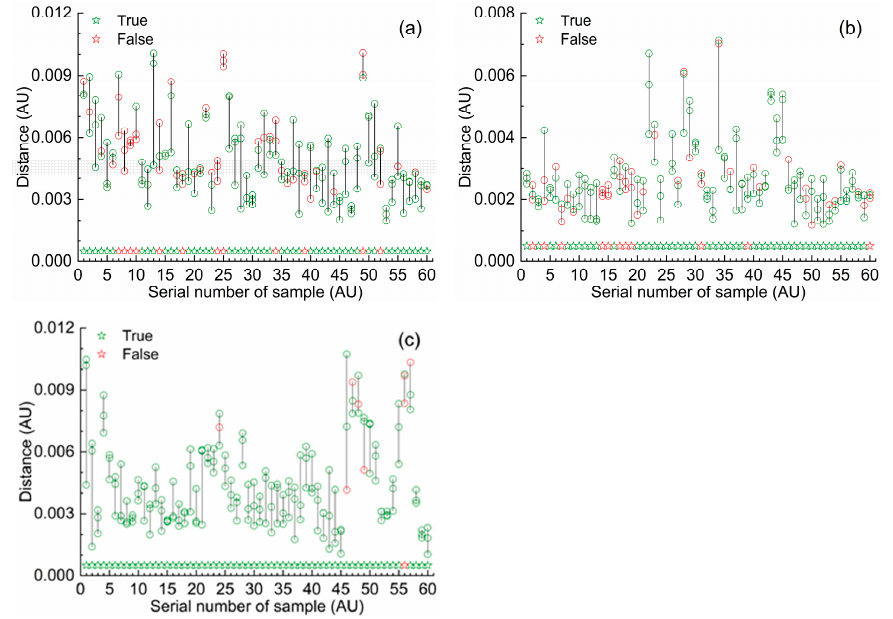
Figure 4. First three shortest distances between each prediction sample and all the calibration samples based on the optimal MW-kNN waveband in the three measurement modals: ( a ) 1-category, 1 mm, 966–1894 nm; ( b ) 2-category, 4 mm, 938–1402 nm; ( c ) 3-category, 10 mm, 964–1378 nm.